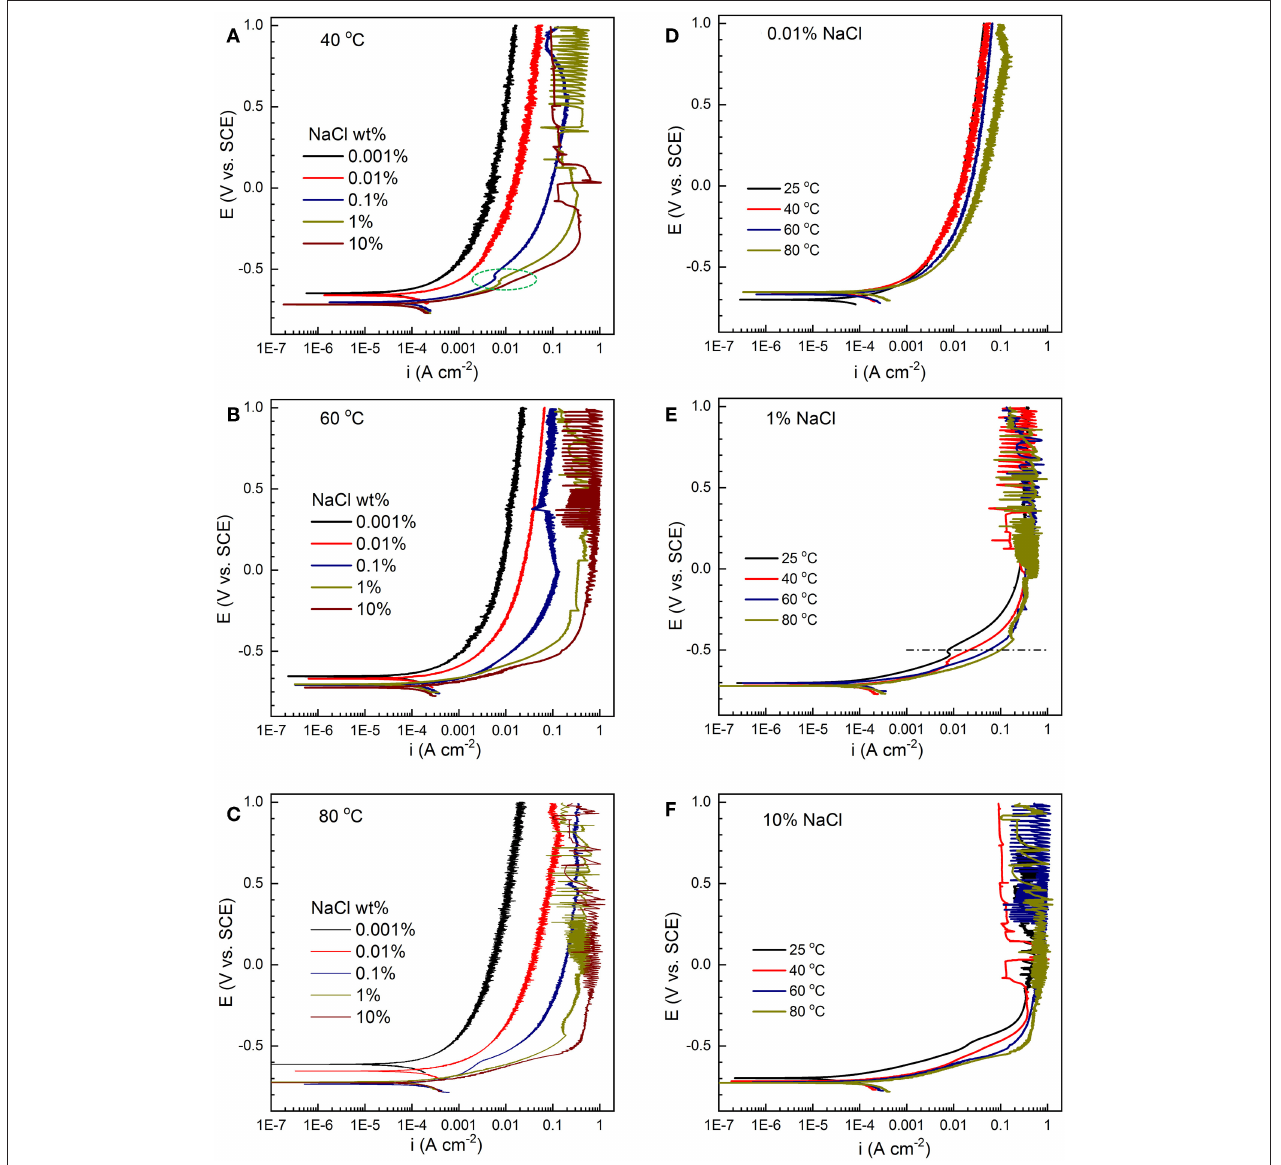
FIGURE 10 | Anodic polarization curves of C1010 steel with varying salt concentration (0.001% to 10%) at constant temperature levels, (A) 40 ◦ C, (B) 60 ◦ C, and (C) 80 ◦ C. Anodic polarization curves with varying temperature (25 to 80 ◦ C) at constant salt concentration levels, (D) 0.01%, (E) 1%, and (F)